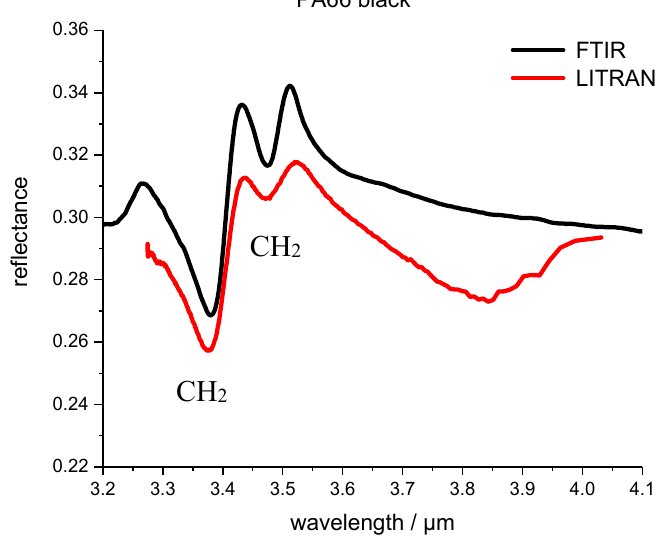
Figure 5. FTIR and LITRAN reflectance spectrum of polyamide 66 (PA 66) black polymer. LITRAN is the spectrum measured with the up conversion system.